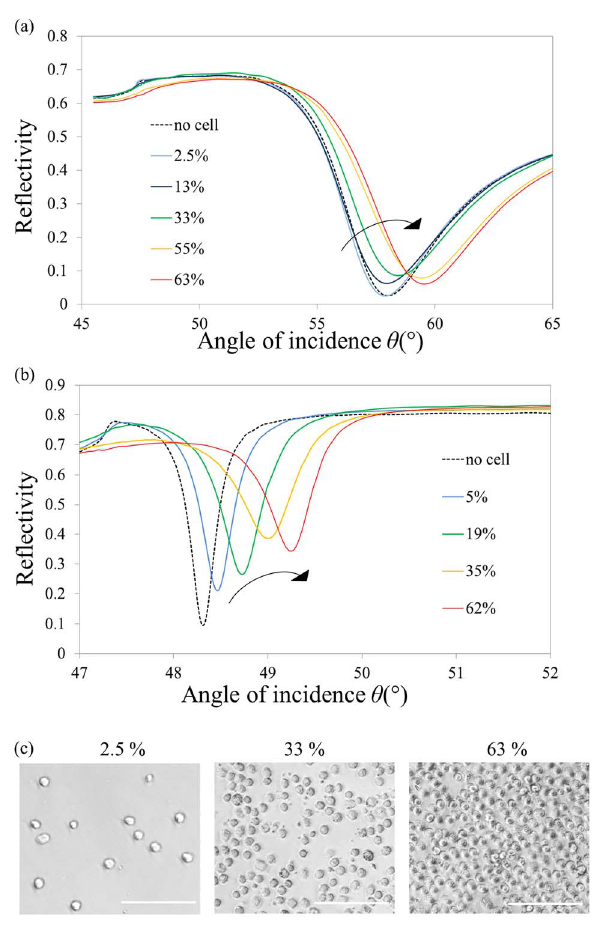
Figure 2. Experimental spectra recorded for cSPR sensors and LRSPR sensors at different cell coverage values. (a) cSPR spectra and (b) LRSPR spectra. The arrows indicate the evolution of the spectra. (c) Micrographs of three different cell coverage values of round 3T3 cells. Scale bar is 100 m m.